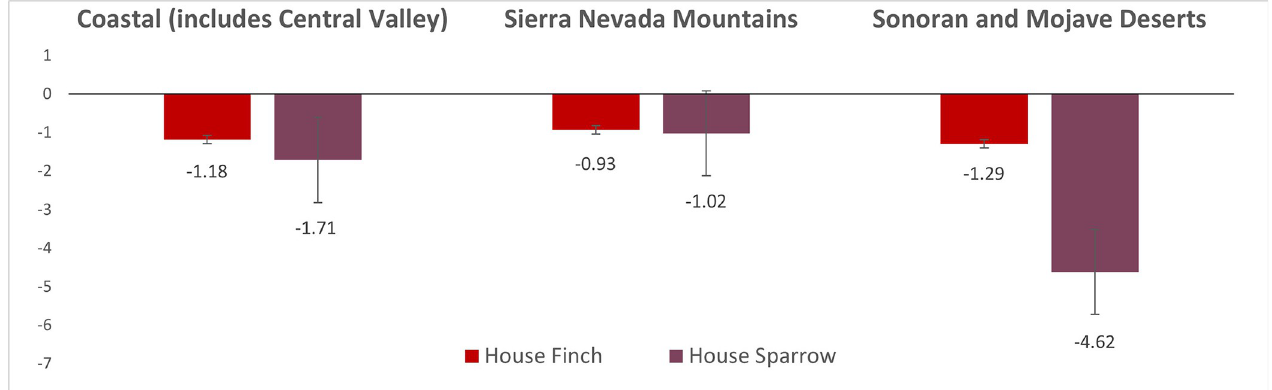
Fig 2. House Finch and House Sparrow population trends in three Bird Conservation Regions (2004–2019): Relative abundance change (%) per year and standard errors.